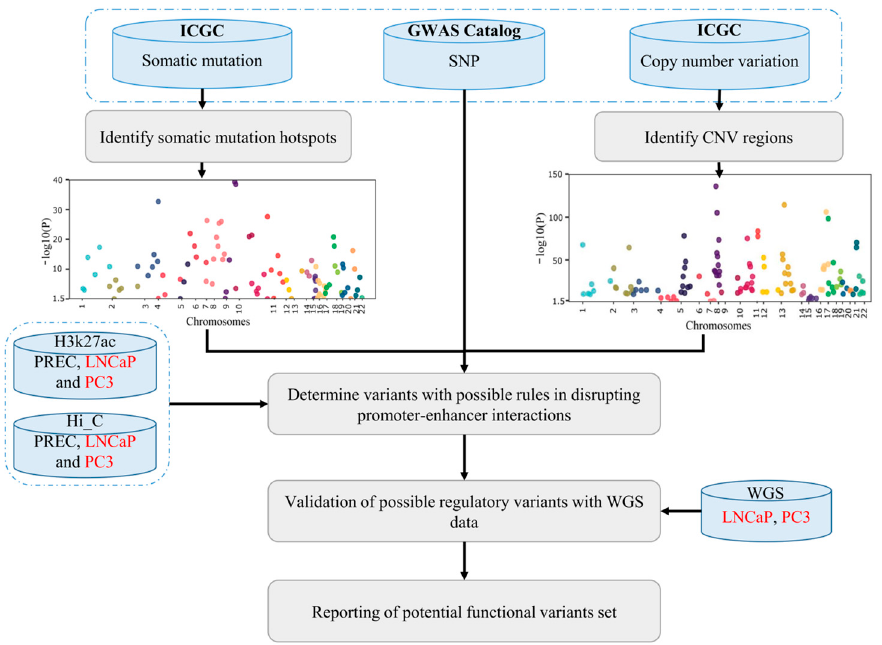
Figure 1. An overview of AGV. The AGV pipeline first makes a list of associated genomic variants including GWAS SNPs, somatic point mutations, and CNV regions. AGV then uses Hi-C and H3K27ac to determine variants with possible rules in disrupting promoter–enhancer interactions. Finally, AGV reports a list of functional genomic variants with a possible role in PC.